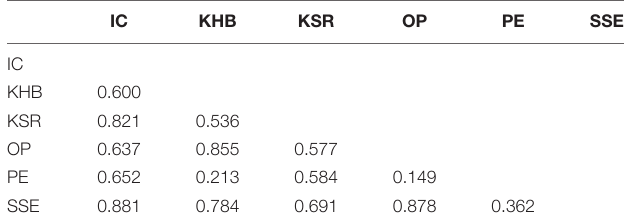
TABLE 2 | Construct reliabilities and AVE. TABLE 3 | HTMT ratio.